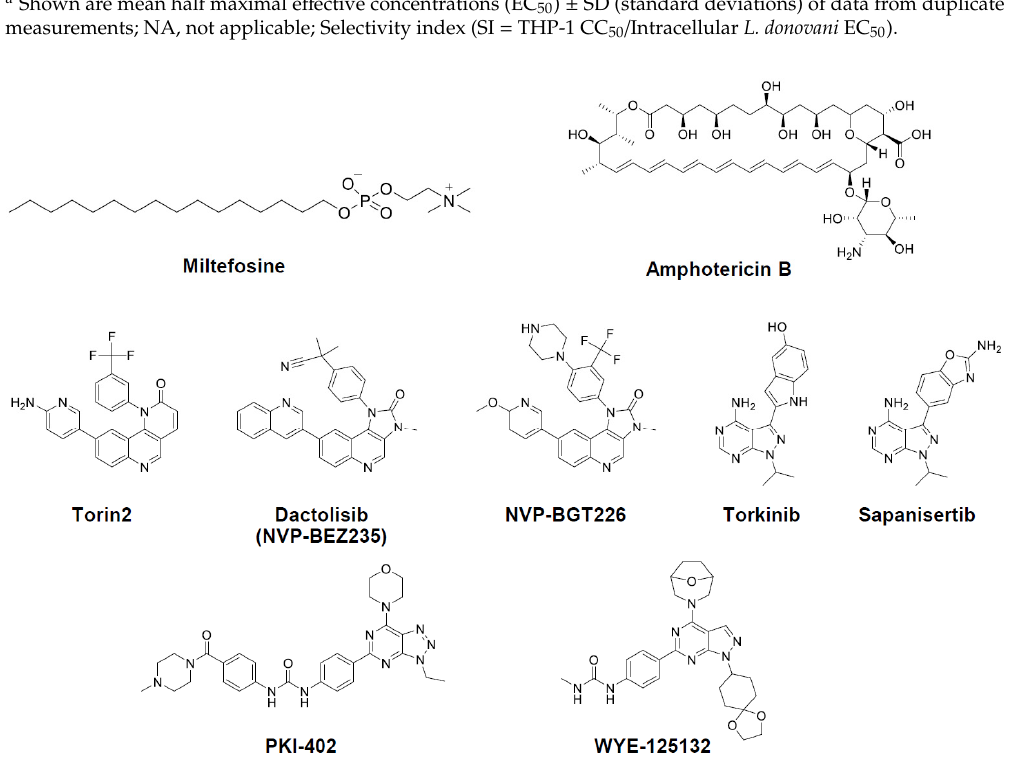
Figure 2. Structures of compounds investigated in this work. Table 1. Efficacy of tested compounds in THP-1 cells infected with intracellular L. donovani, L. donovani promastigote growth; and T. brucei bloodstream form.